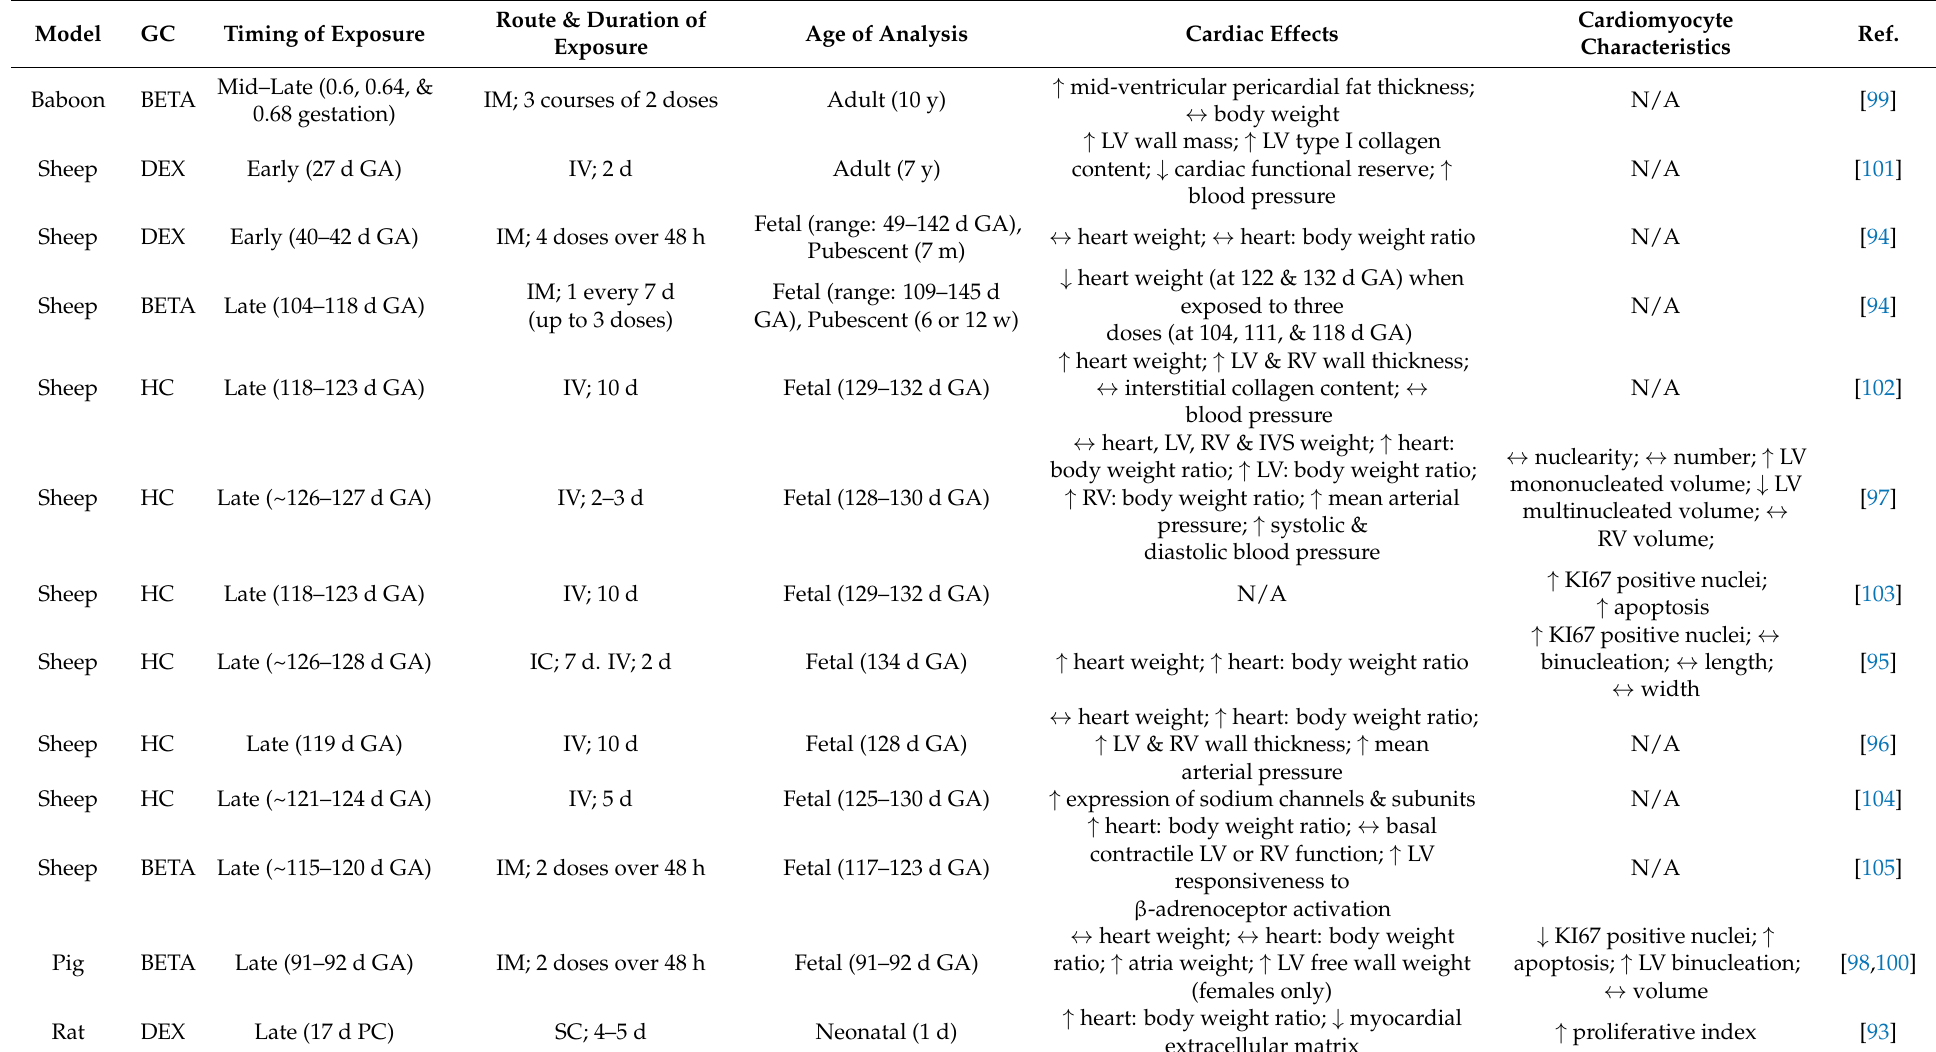
Table 1. Effects of antenatal glucocorticoid administration on the